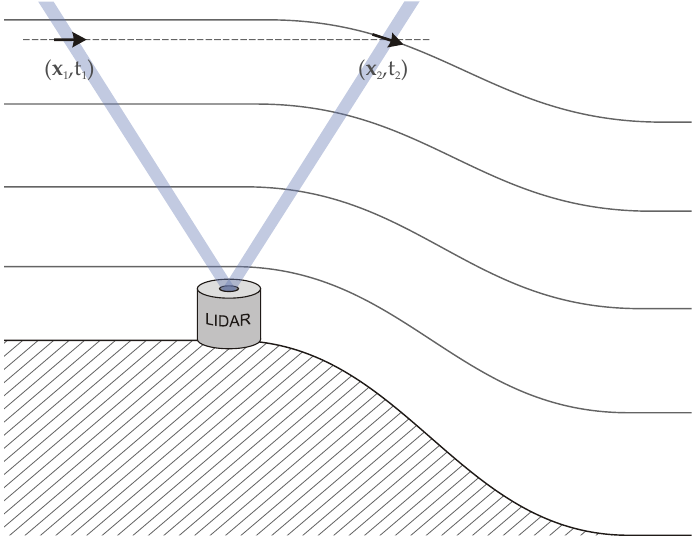
Figure 1. A monostatic lidar generally introduces a large measurement uncertainty when operating over complex terrain. This is the result of calculating the horizontal velocity based on the difference of varying radial wind velocities measured at different locations and times within a single measurement cycle in which the measurement beam is tilted in different